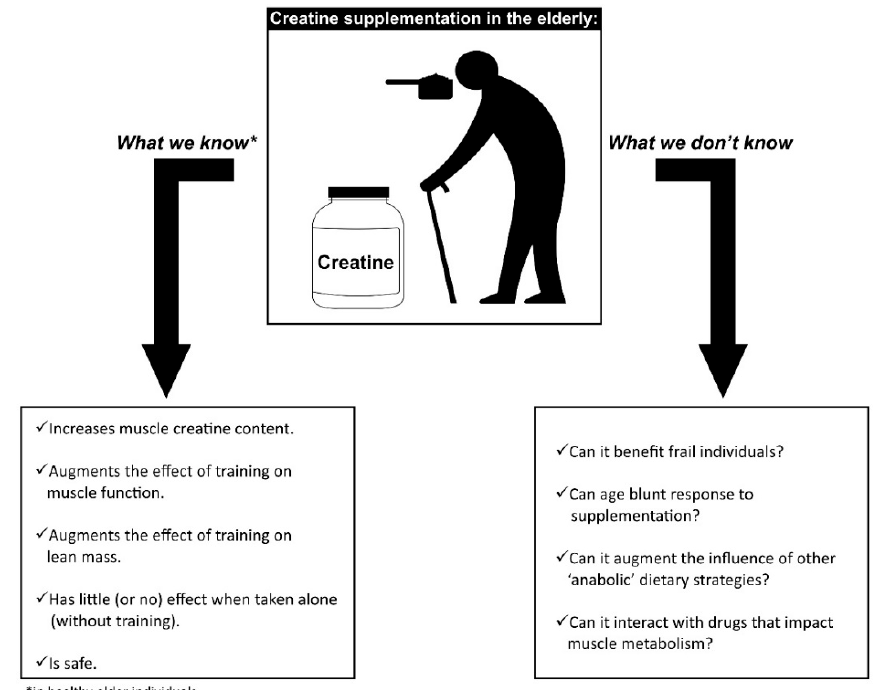
Figure 1. Overview of the state of knowledge about the influence of creatine supplementation on muscle mass and function in older adults.